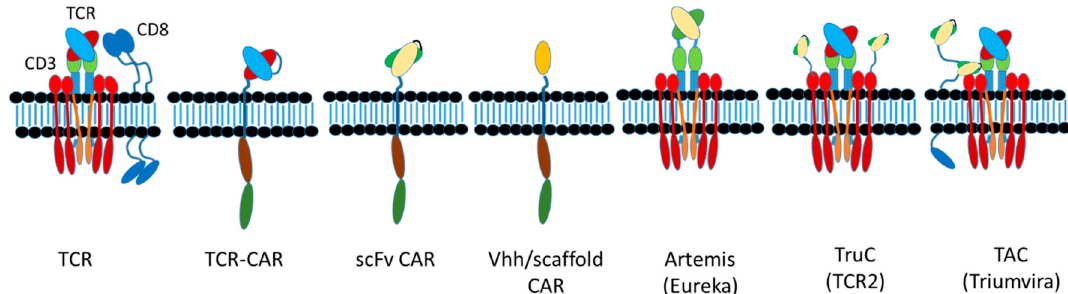
Figure 10. Schematic representation of various CAR formats. Left, natural organization of a CD8 + TCR expressed on cytotoxic T cells driving MHC-restricted CD8 + T cell effects. TCR-CARs are formed by fusing the TCR α / β variable domains to a second-generation CAR scaffold. The Eureka Therapeutics Artemis platform fuses antibody variable domains to TCR α / β constant regions. TCR2 platform fuses scFvs to CD3 ε . Triumvira platform fusing two scFv chains to CD8 stalk, hinge and intracellular domains-one scFv binds to CD3 ε engaging the rest of the TCR complex, while the second is free to interact with tumor antigens.